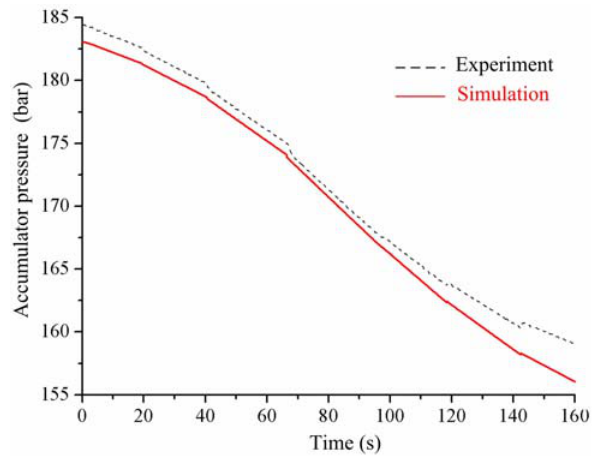
Figure 14. Accumulator pressure responses of the HESGS under varied load power step.